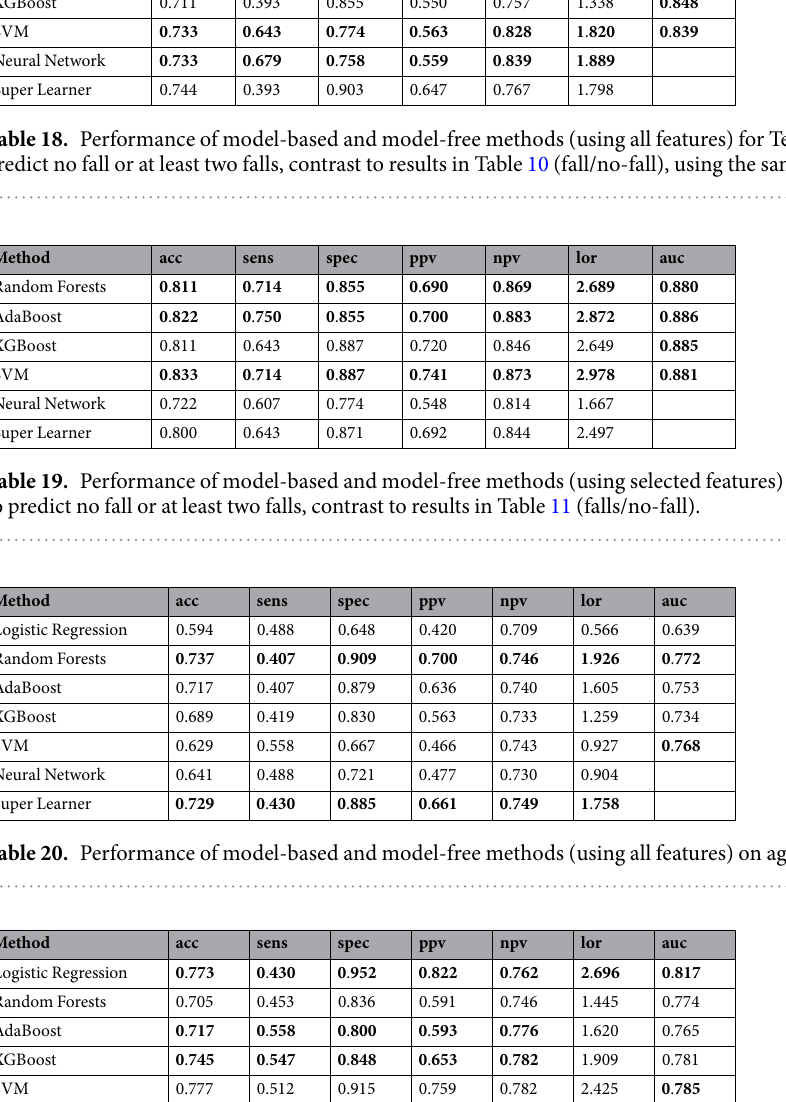
Table 17. Distribution of patients without fall history compared to patients with two or more falls.